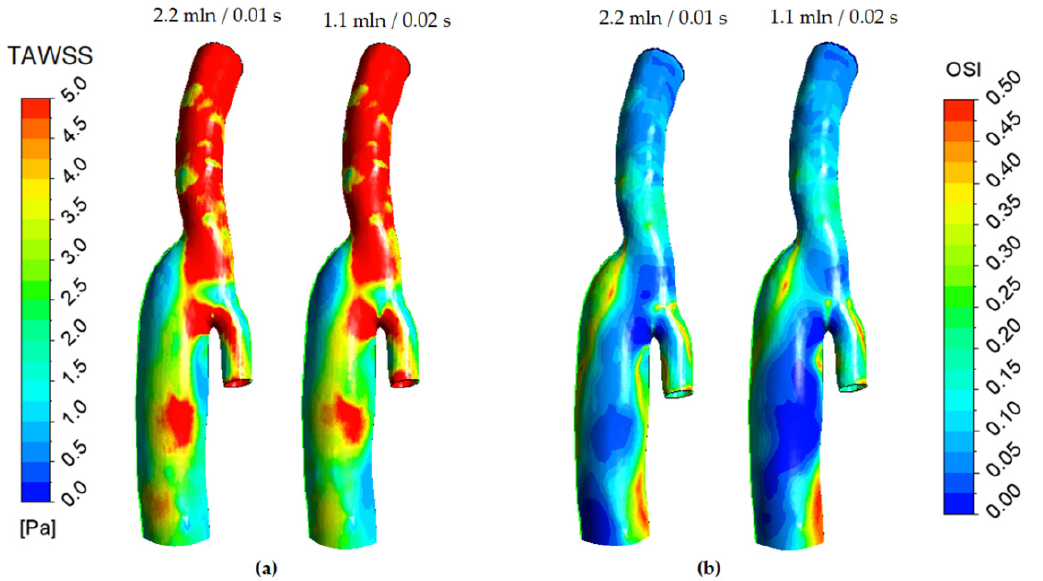
Figure 5. Distributions of ( a ) TAWSS and ( b ) OSI computed for patient-specific model 2 with different numerical resolutions.